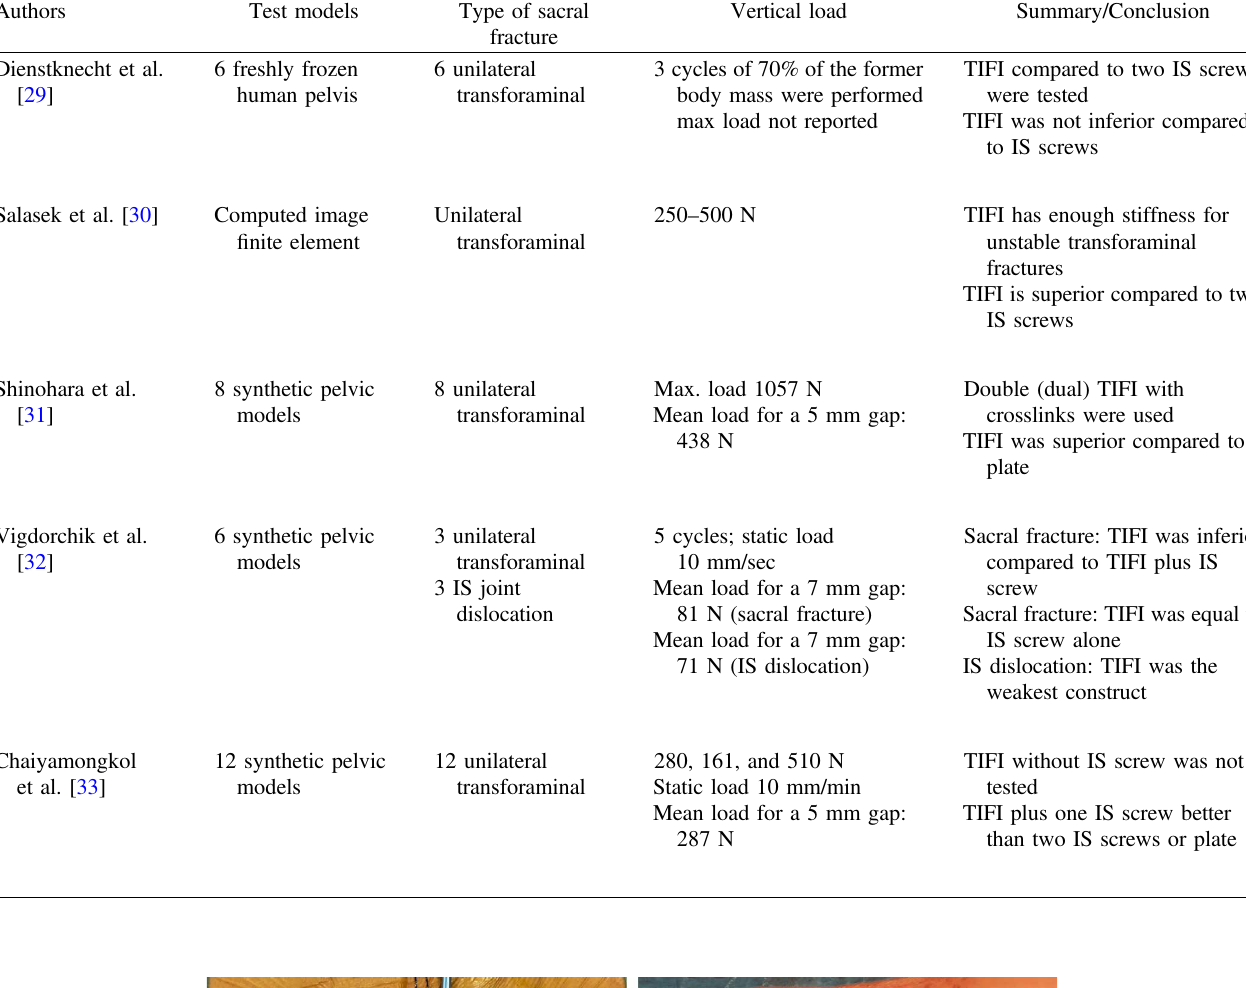
Table 2. Biomechanical test series with TIFI.